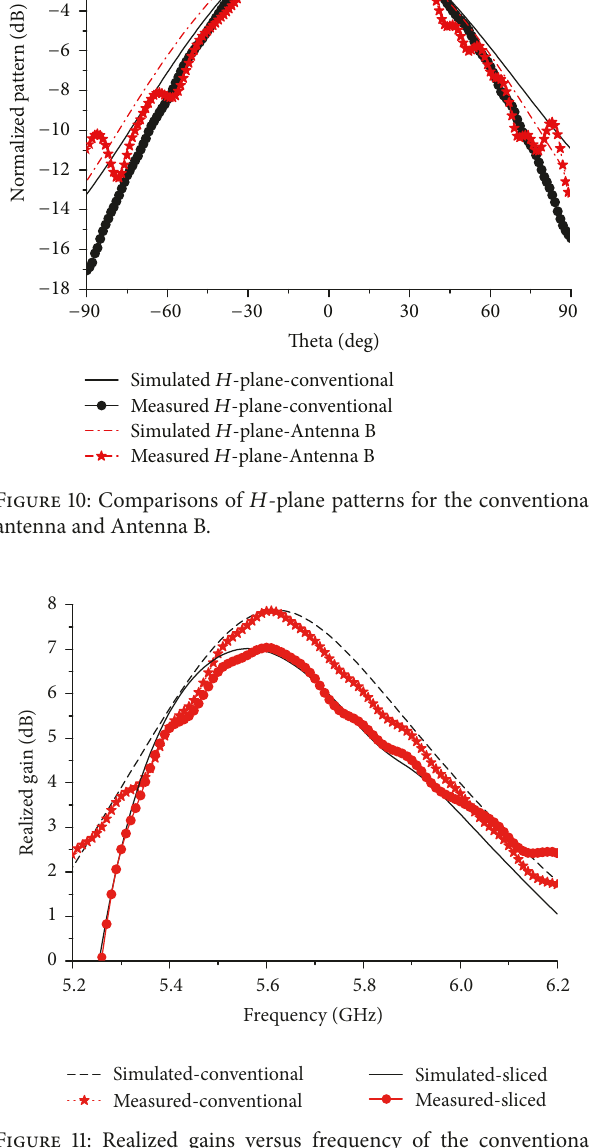
Figure 11: Realized gains versus frequency of the conventional antenna and Antenna